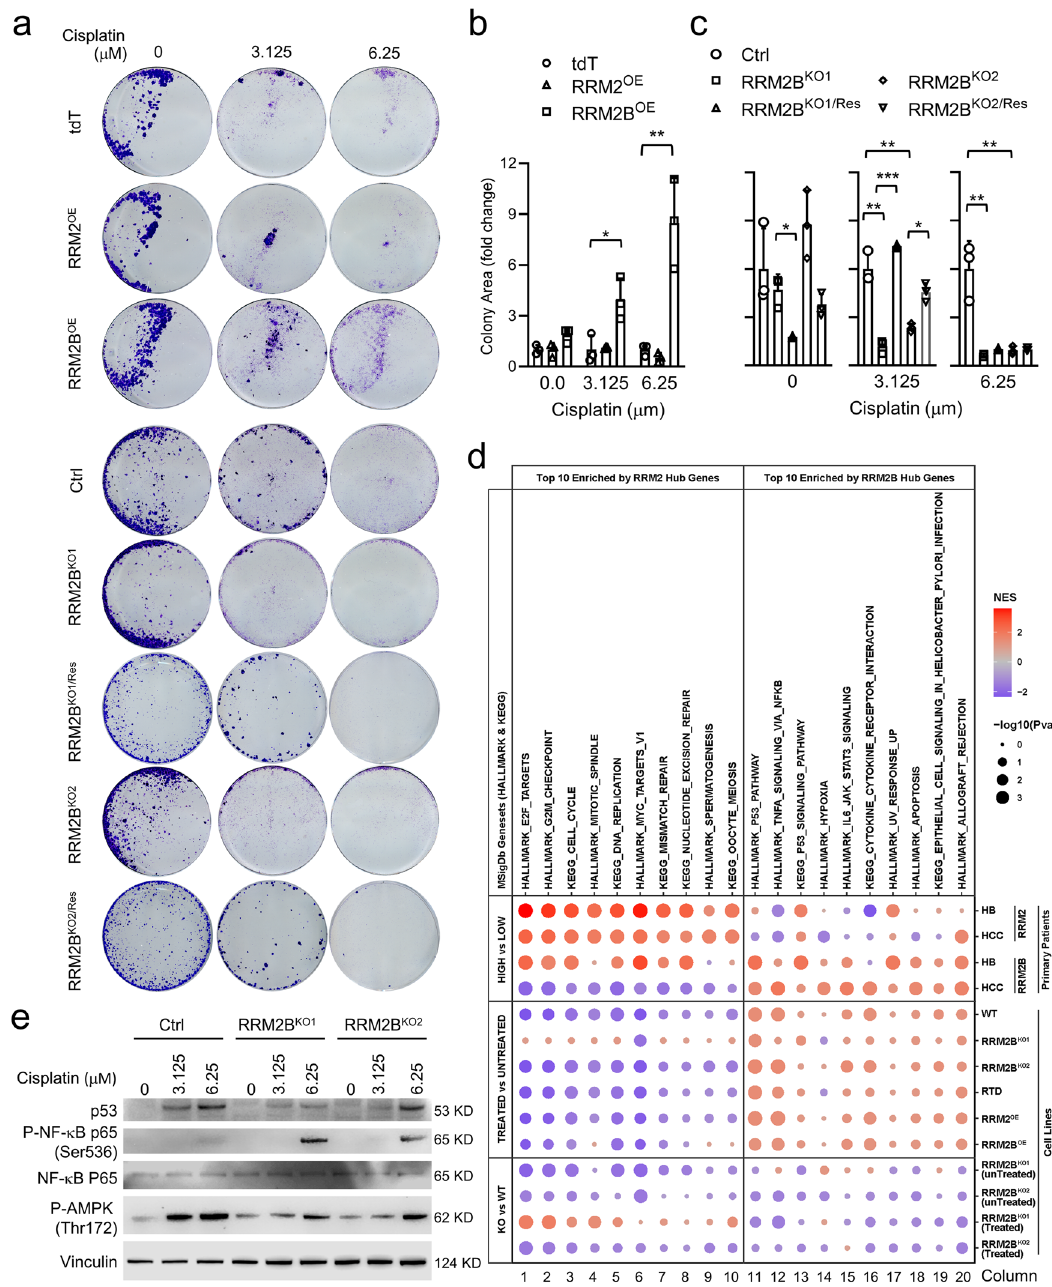
Fig. 6 RRM2B, not RRM2, supports post-drug treatment recovery of HB cells in vitro. a 12-day colony formation assay of the indicated RRM2- and RRM2B -manipulated HepG2 cells post cisplatin treatment at two different concentrations. b , c Quantitative comparison the colony area occupied by cells in (A) ( n = 3 for each group). Student t test. P values: * <0.05, ** <0.01, *** <0.001. d Gene set enrichment analysis of HALLMARK and KEGG gene sets using pre-ranked gene list by fold change of gene expression across different comparisons of the indicated HB cells and patient tumors. The size and color intensity of the bubbles indicate the normalized enrichment score and statistical signi fi cance, respectively. e Immunoblotting of the indicated proteins in the cisplatin-treated RRM2B KO